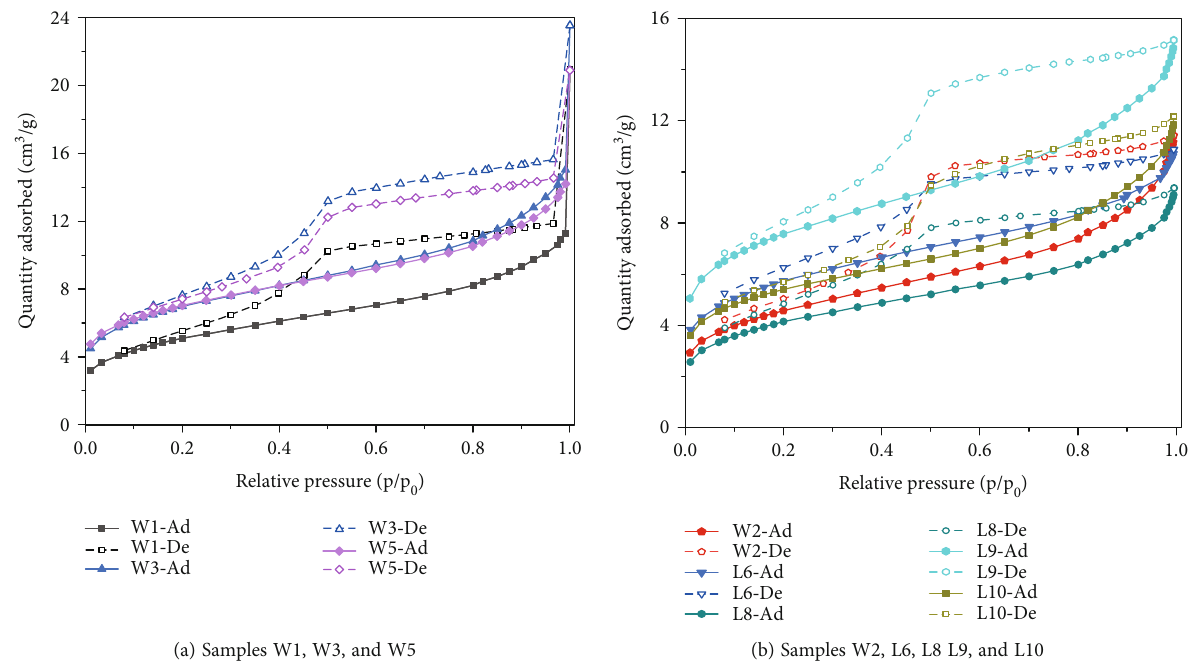
Figure 2: Low-temperature nitrogen adsorption isotherm curves of the deep Longmaxi Formation shale.